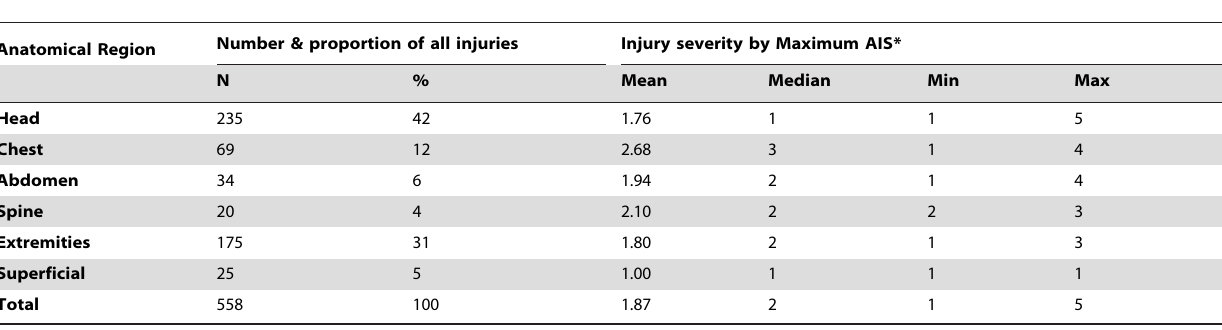
Table 4. Traffic-related injury hospitalisations by anatomical region and AIS severity, Al Ain, 2006–2007 (n =558 regions).